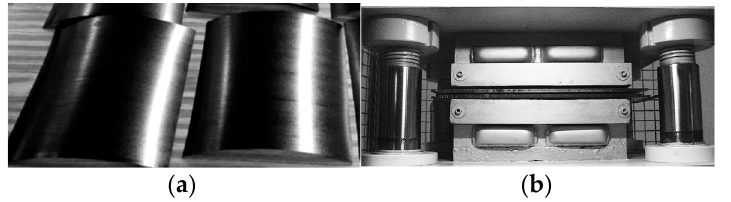
Figure 5. Manufacturing process of the test specimens: ( a ) Prepregs samples before stacking; ( b ) Closed-mold placed in the press